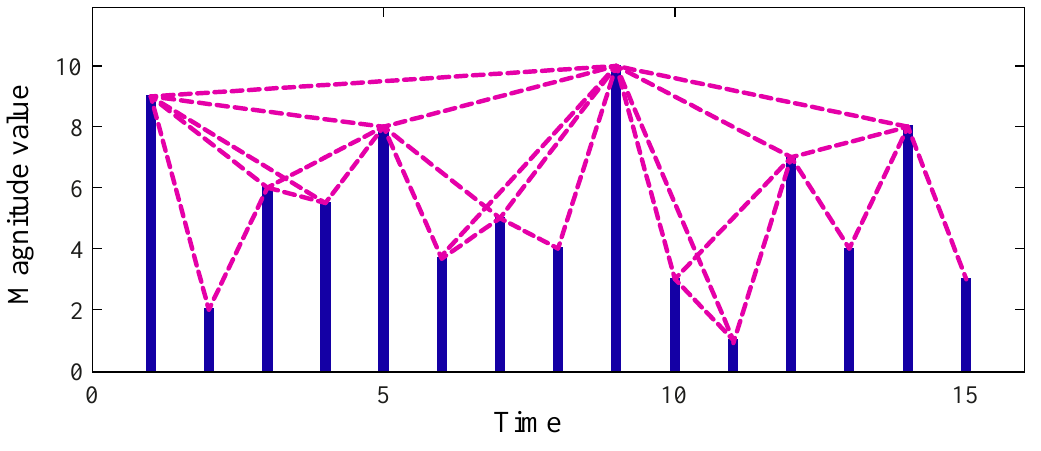
Figure 1. The visibility graph of a time-series.